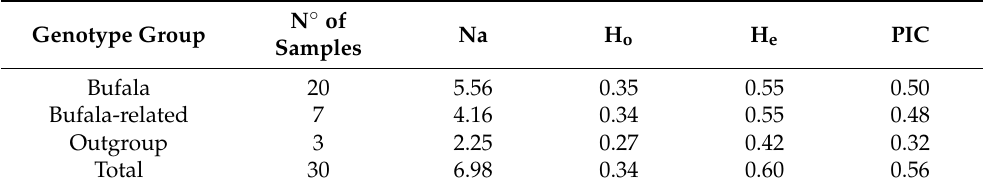
Table 2. Genetic diversity estimated for tetraploid wheats. Na = average number of alleles; H o = average observed heterozygosity; H e = average expected heterozygosity; PIC = average poly- morphic information